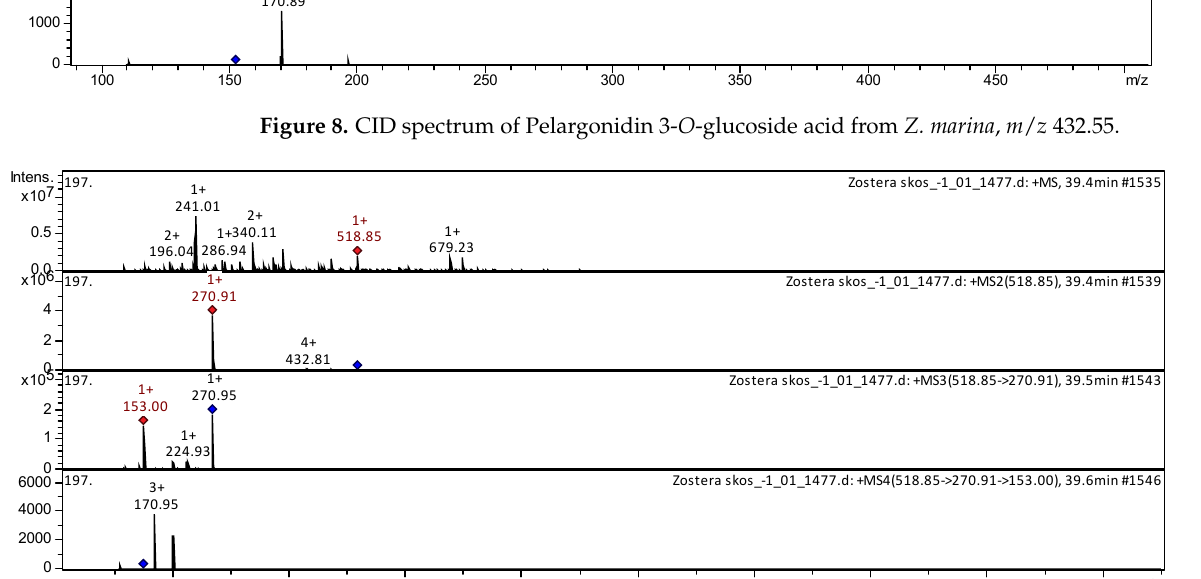
The CID spectrum in negative ion modes of flavonol Kaempferol 7-sulfate from Z. marina is shown in Figure 10. [M–H] – ion produced one fragment ion with m/z 284.92 (Fig- ure 10). The fragment ion with m/z 284.92 formed four daughter ions with m/z 266.90, m/z 256.96, m/z 238.98, and m/z 213.03. It was identified in the bibliography in extract from F. pulverulenta Frankeniaceae [12].